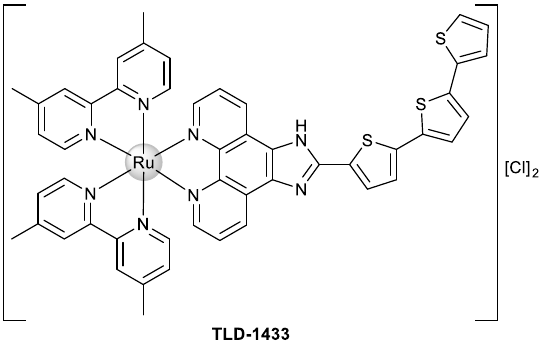
Figure 1. Chemical structure of Ru(II) – polypyridyl complex TLD-1433.